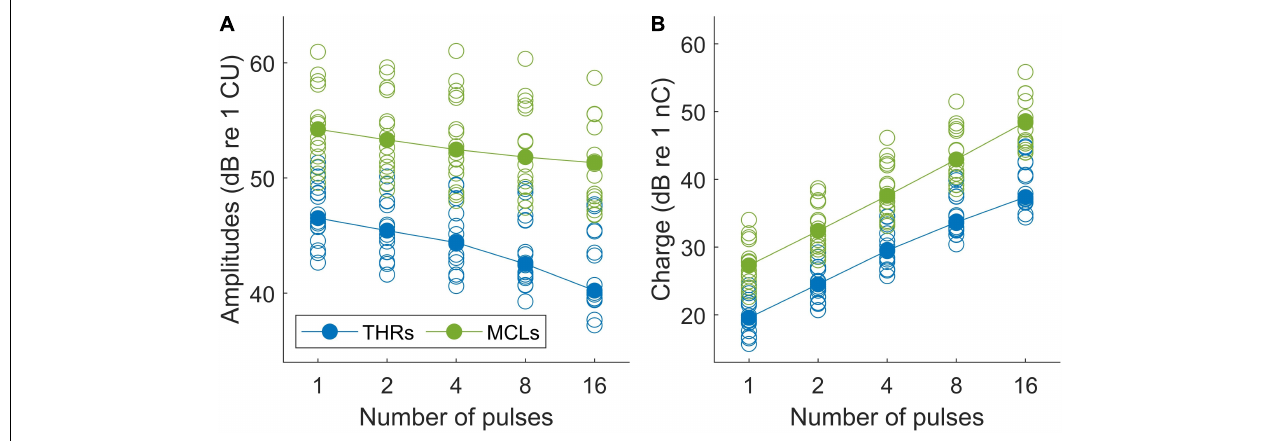
FIGURE 6 | (A) Psychophysical THR and MCL currents (in dB re 1 µ A) and (B) total burst charge (TBC) (dB re 1 nC) for 14 subjects (19 ears). Values differed significantly between all conditions ( p < 0.05).